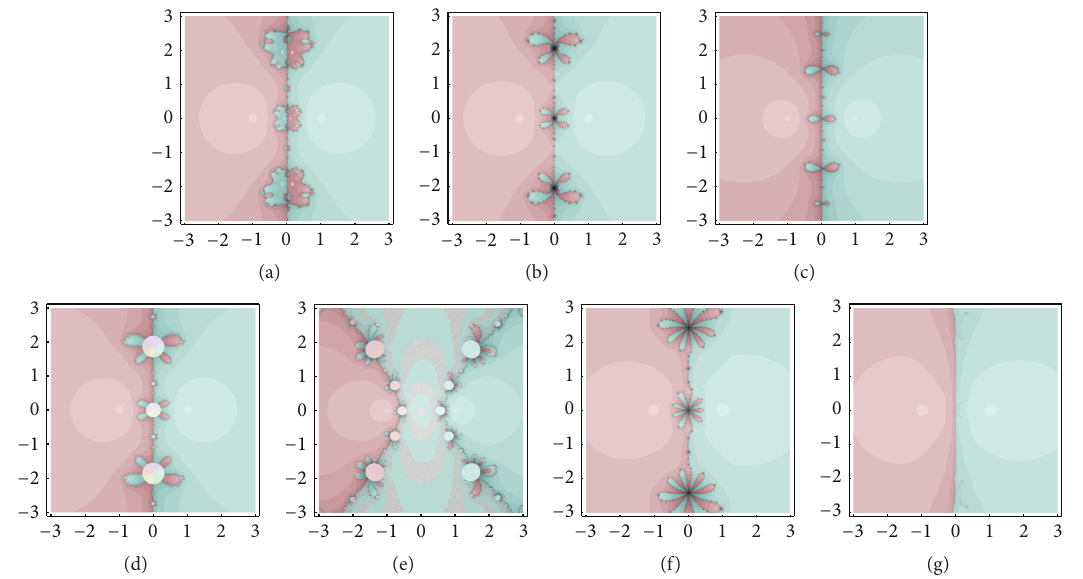
Figure 4: (a) for Kan , (b) for Sol , and (c) for Zhou and (d) for 1D , (e) for 1G , (f) for 2D , and (g) for 2G , for the roots of the polynomial (𝑧) = (𝑧 2 − 1) 7 𝑃 4